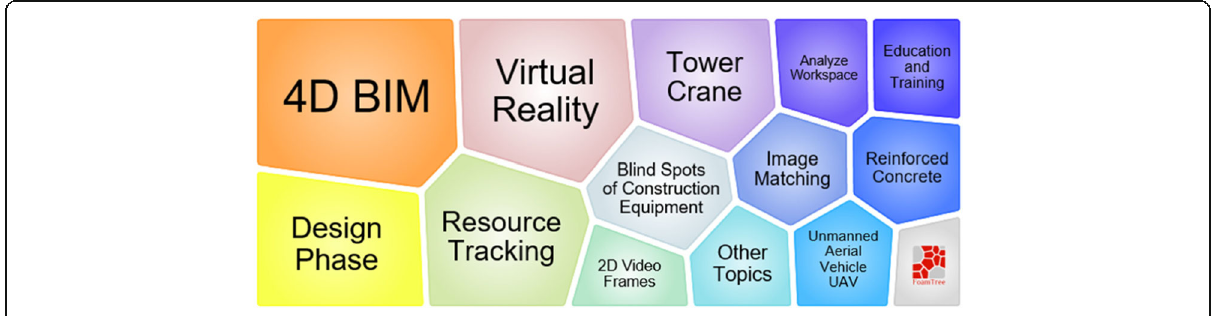
Fig. 14 Foam tree view of keywords in topic